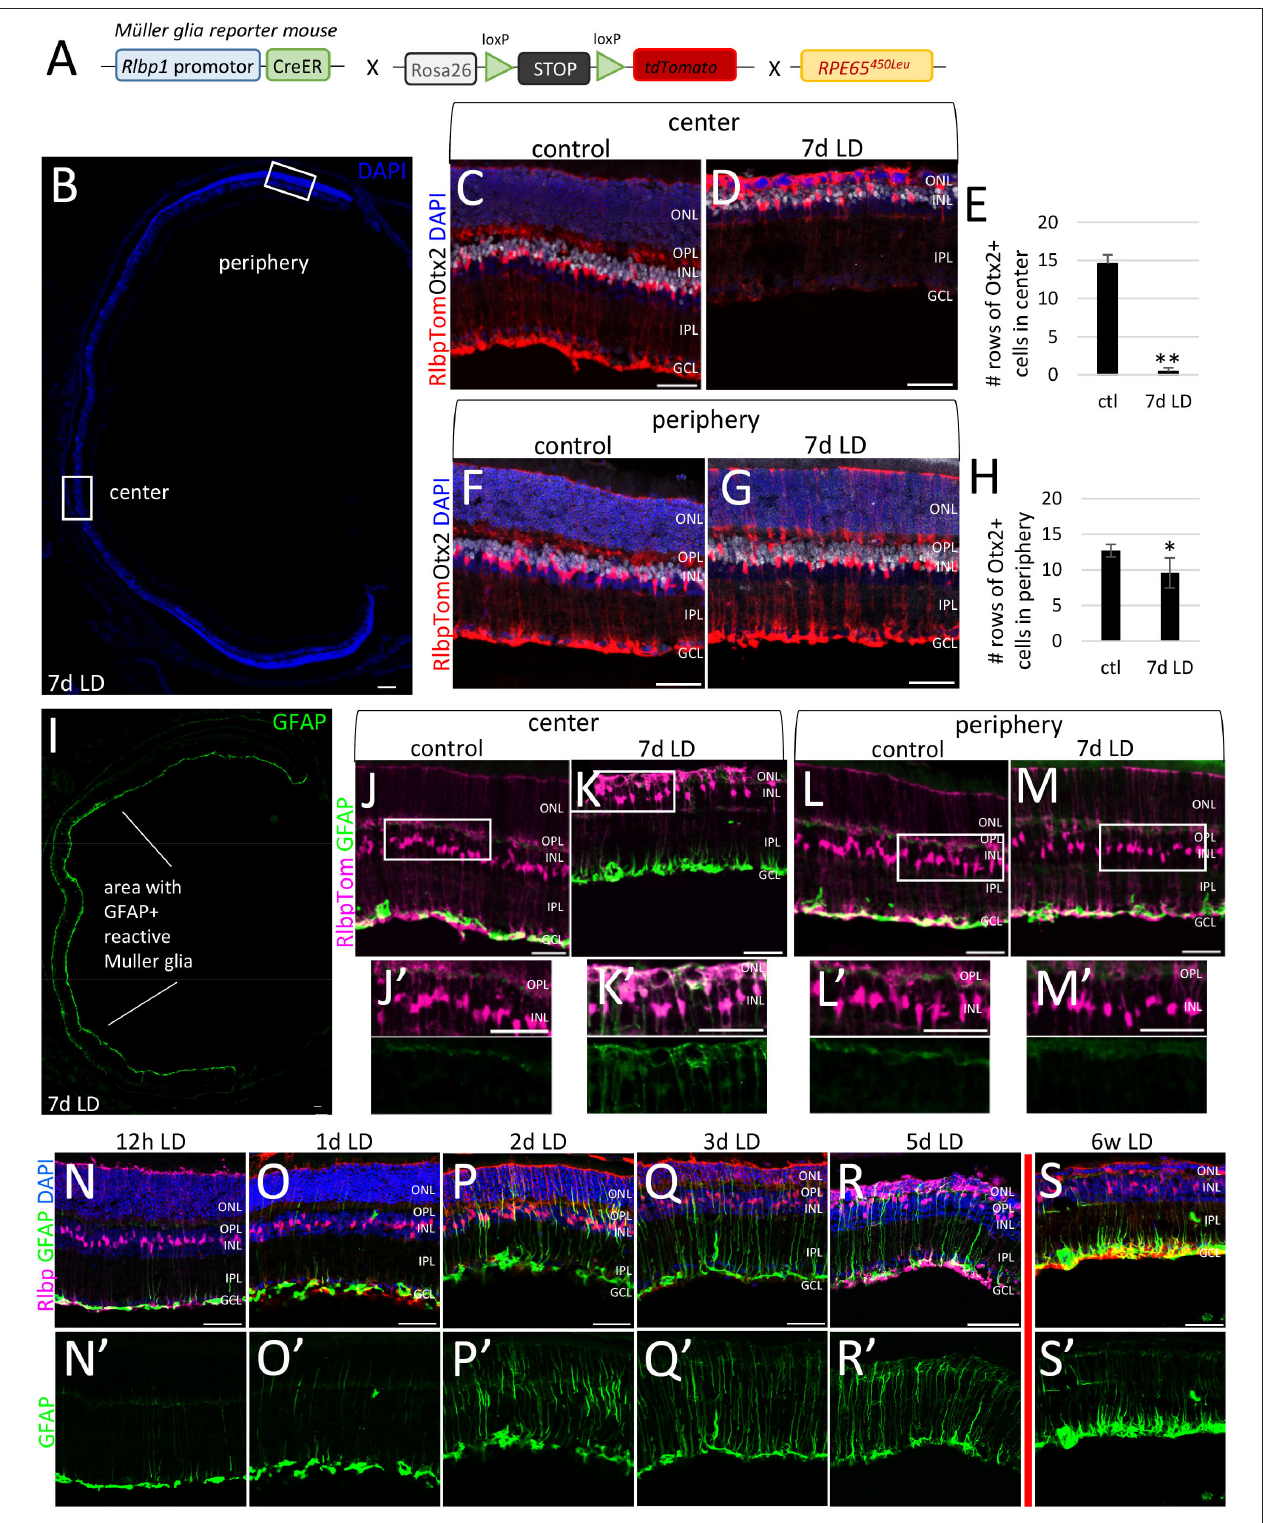
FIGURE 1 | Neuronal loss and gliosis in the central and peripheral retina after light damage. (A) Schematic of the RlbpCreER: stop f / f -tdTomato: RPE65 450 Leu mouse. (B) Cross section of DAPI-labeled retina 7 days after light damage with regions of analysis. (C–G) Immunofluorescence labeling for tdTomato (MG), Otx2, and DAPI nuclear staining of center (C,D) and peripheral areas (F,G) of undamaged and light damaged (7d LD) retinal sections. (E) Number of vertical cell rows of Otx2 +